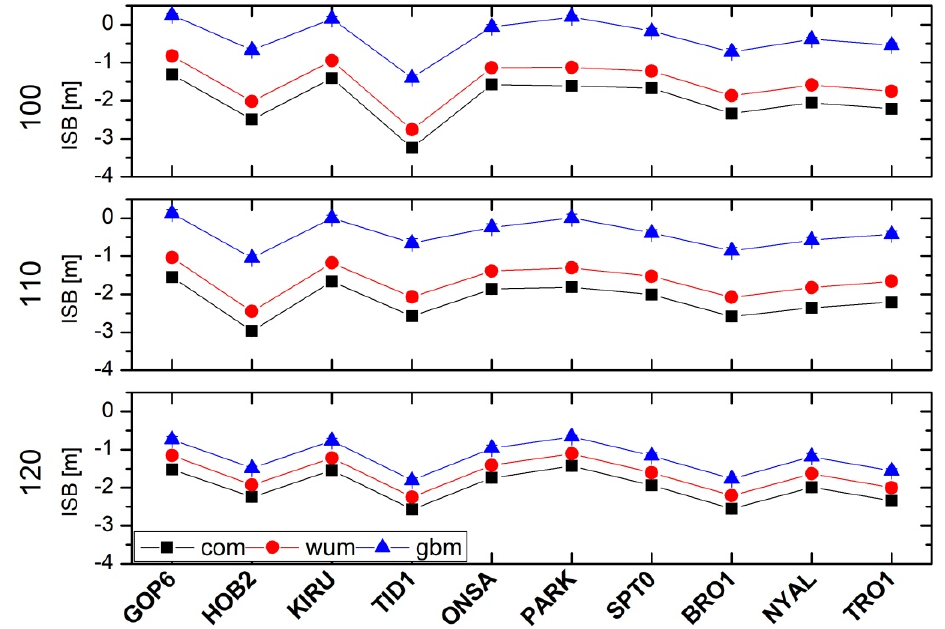
Figure 2. Daily variations in ISB between BDS-3 and BDS-2 for 10 stations. The panels from top to bottom show the results of the com, wum, and gbm precise products.